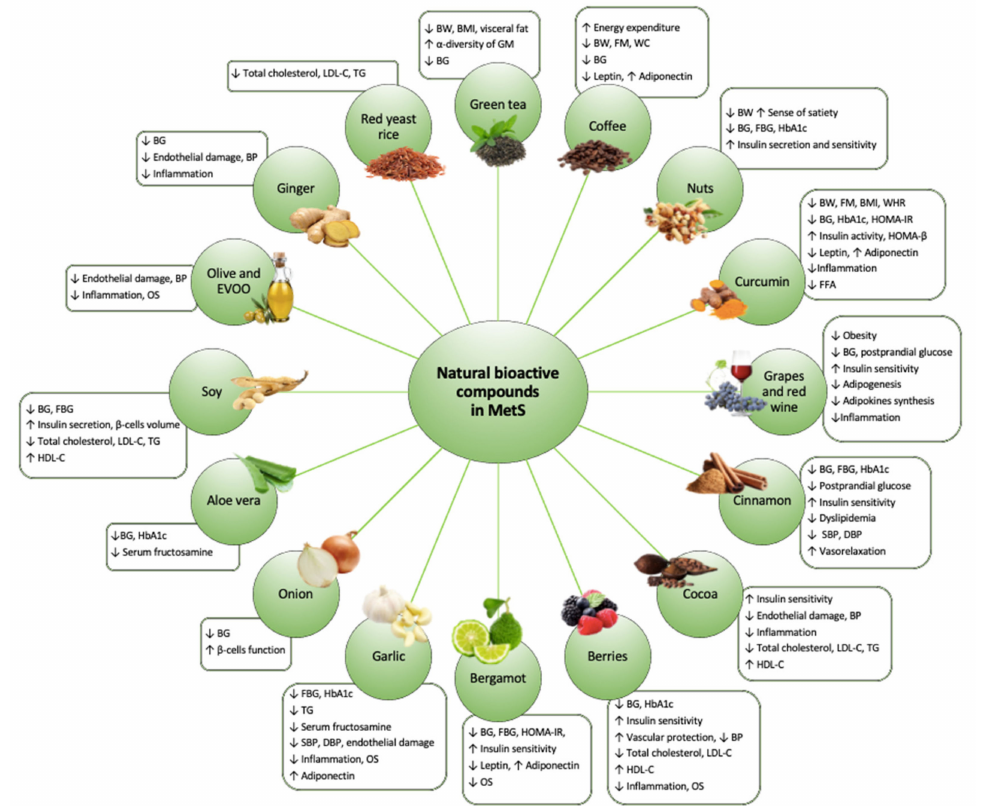
Figure 2. The effects of natural bioactive compounds on Metabolic syndrome management. Abbreviations: ↑ , Increase; ↓ , Decrease; BG, Blood glucose; BMI, Body mass index; BP, Blood pressure; BW, Body weight; DBP, Diastolic blood pressure; FBG, Fasting blood glucose; FFA, Fatty free acids; FM, Fat mass; GM, Gut microbiota; HbA1c, Hemoglobin A1c; HDL-C, High-density lipoprotein cholesterol; HOMA-IR, Homeostatic model assessment for insulin resistance; HOMA- β , Homeostatic model assessment for β -cell function; LDL-C, Low-density lipoprotein cholesterol; OS, oxidative stress; SBP, Systolic blood pressure; TG, Triglycerides; WC, Waist circumference, WHR, Waist to hip ratio. Table 2. NBCs in body weight and body composition management. NBCs Studies